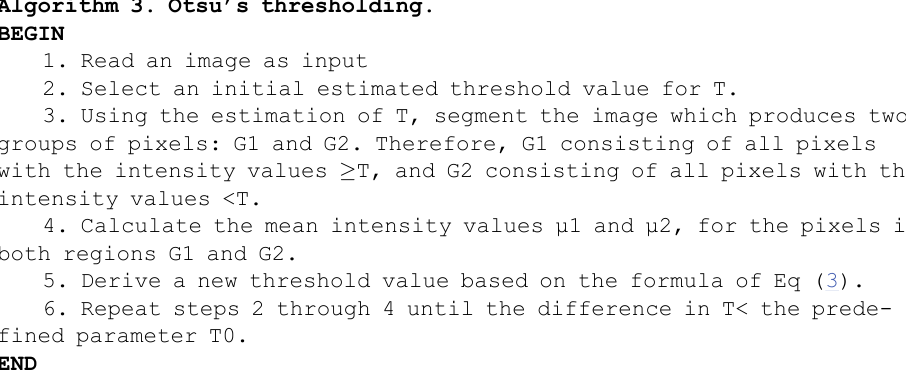
Algorithm 3. Otsu’s thresholding.